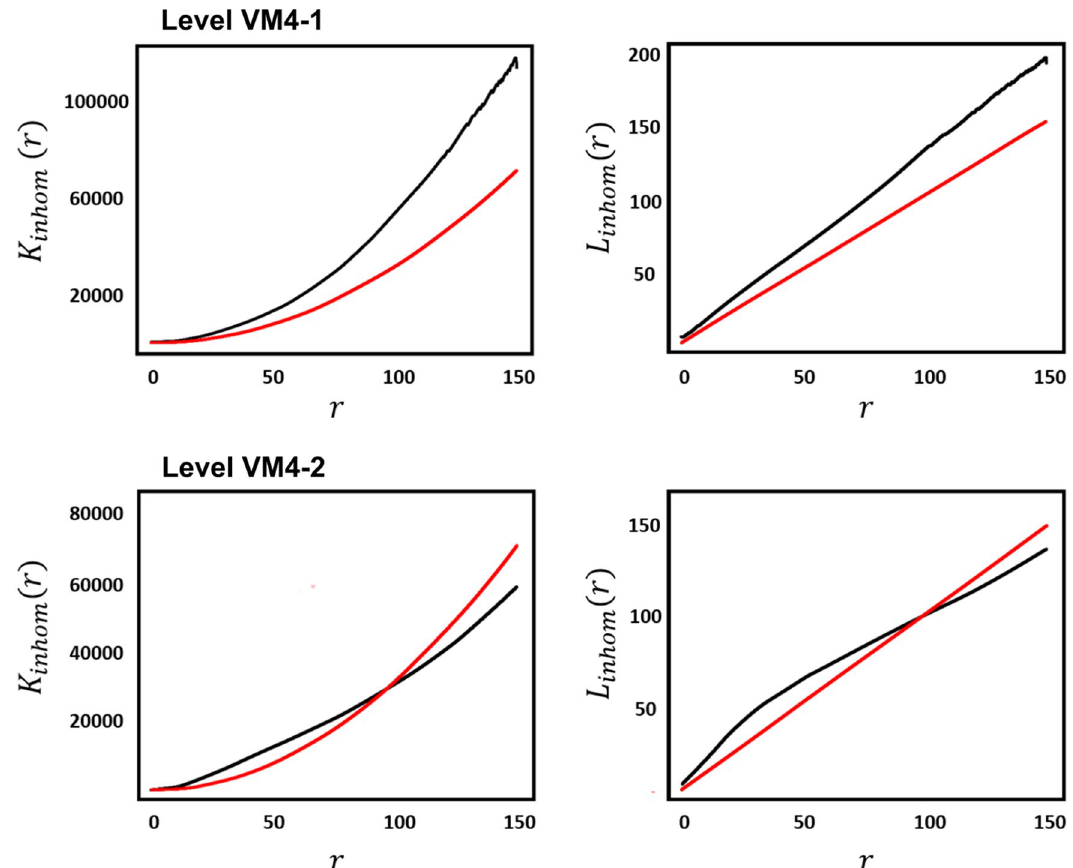
Figure 6. Stereograms presenting general orientation and plunge patterns across both the VM4-I and VM4-II levels. Localized stereograms were obtained according to the detected clusters in Figure. Numeric data relating to these graphs can be consulted in Supplementary Methods.